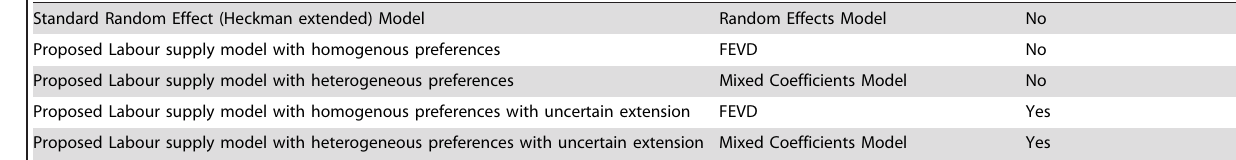
Table 2. Overview of Proposed Models.